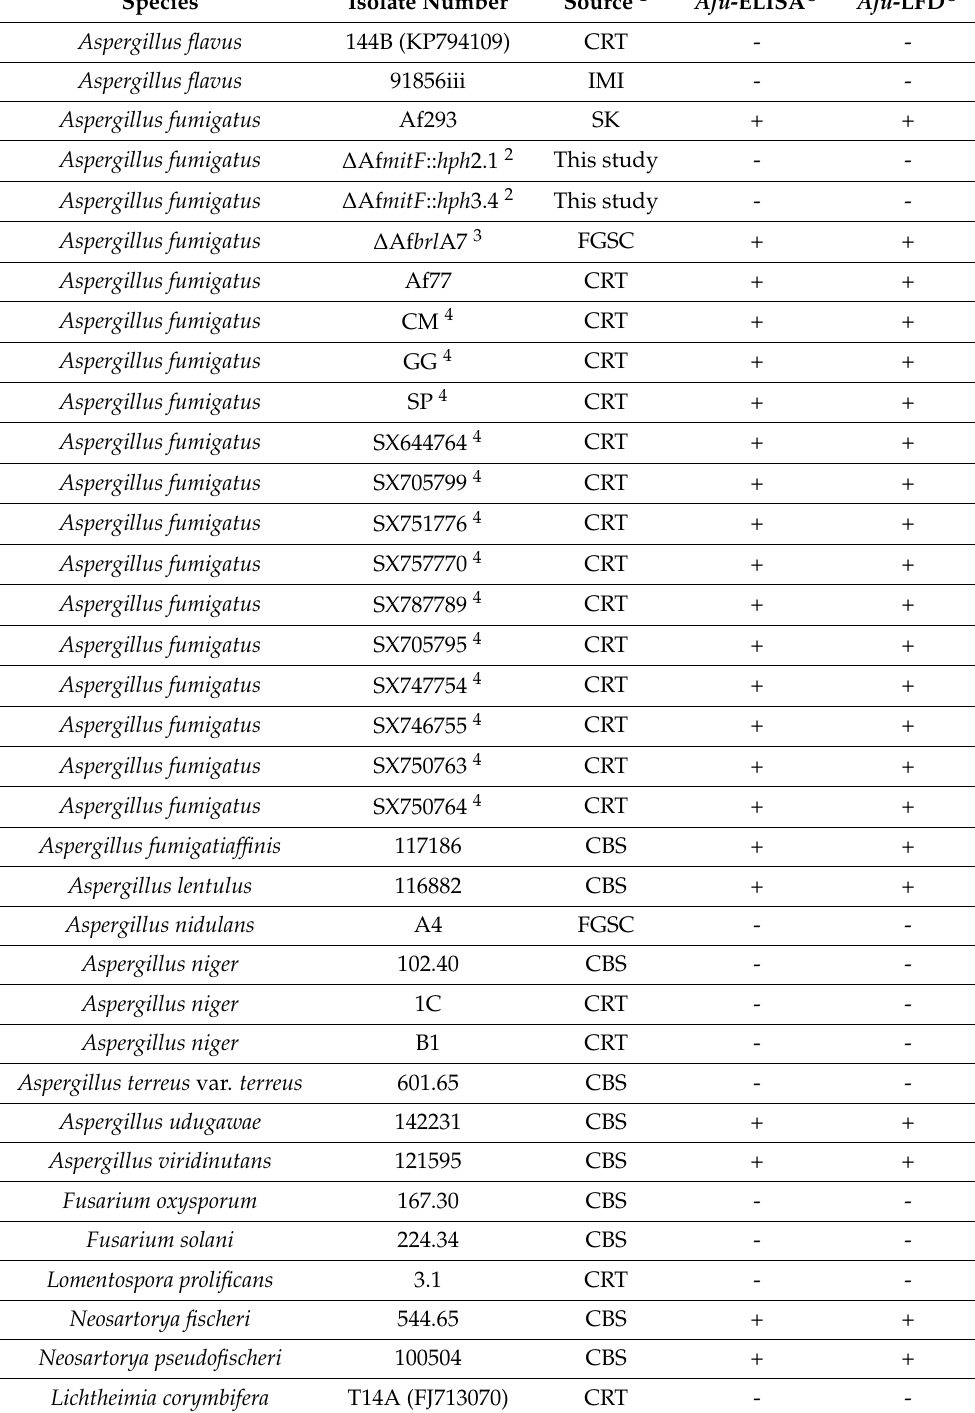
Table 1. Details of fungi used in this study, and summary of Afu -ELISA ® and Afu -LFD ® specificities. Species Isolate Number Source 1 Afu -ELISA ® Afu -LFD ® Aspergillus flavus 144B (KP794109) CRT - - Aspergillus flavus 91856iii IMI - - Aspergillus fumigatus Af293 SK + + Aspergillus fumigatus ∆ Af mitF :: hph 2.1 2 This study - - Aspergillus fumigatus ∆ Af mitF :: hph 3.4 2 This study - - Aspergillus fumigatus FGSC + Aspergillus fumigatus Af77 CRT + Aspergillus fumigatus CM 4 CRT + Aspergillus fumigatus